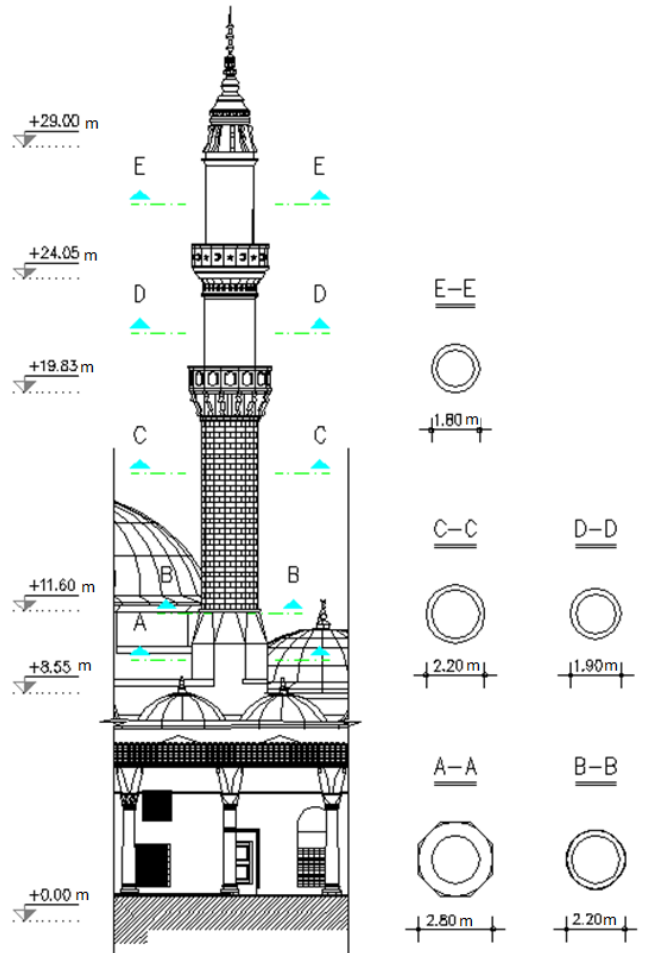
Figure 4. Architectonic façade and cross-sections.